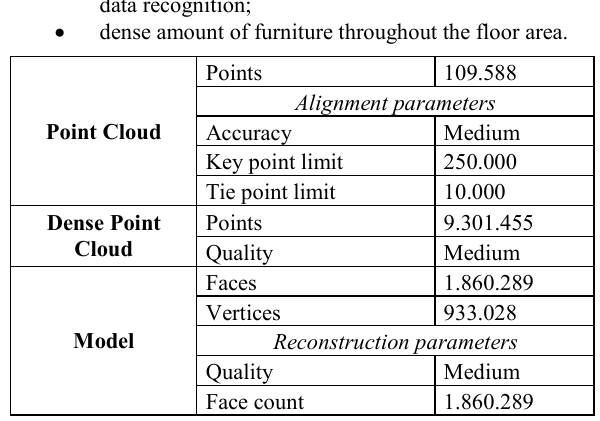
Table 2. Processing Parameters from PhotoScan Report - ‘Camera grande del letto’